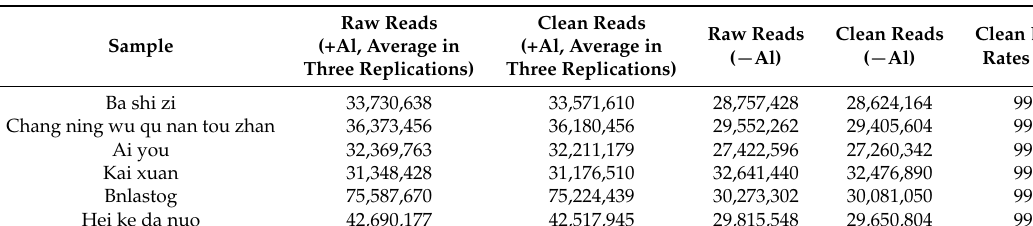
Table 1. Summary of RNA sequencing.